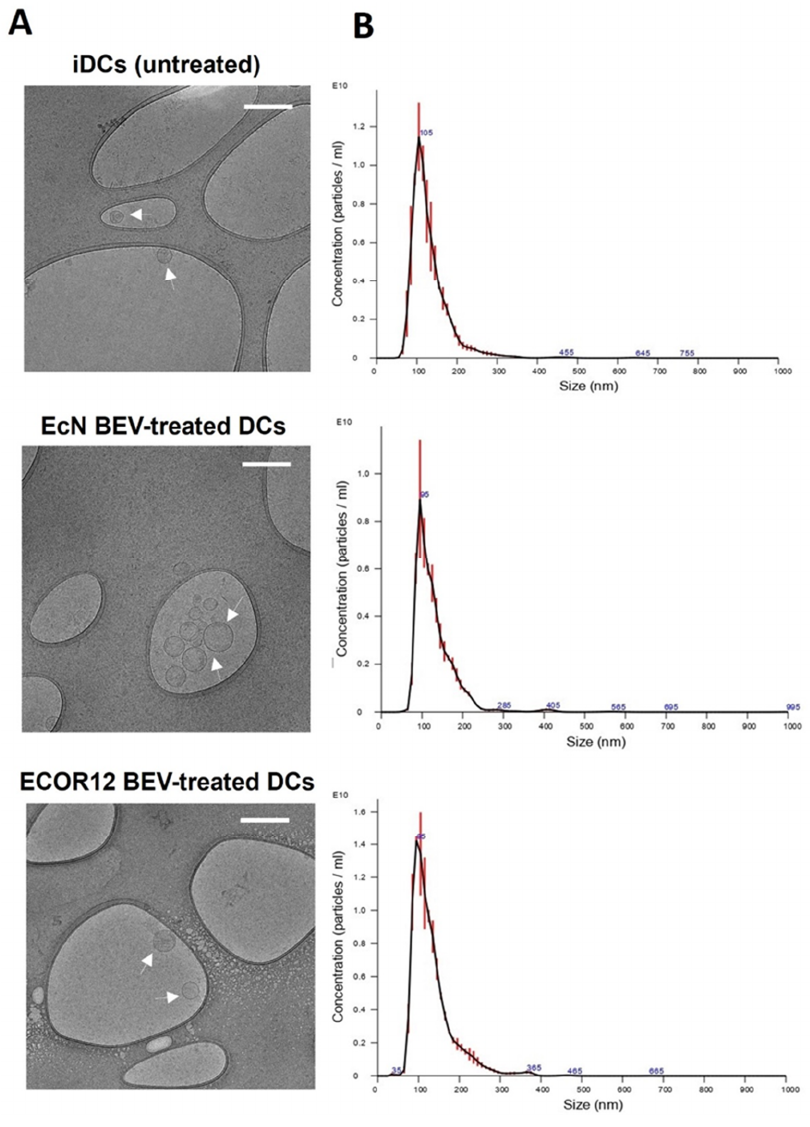
Figure 3. Characterization of EVs produced by mo-DCs in response to BEVs from the probiotic EcN or the commensal ECOR12. DC-derived EVs were isolated from culture supernatants by differential ultracentrifugation. Samples correspond to the final 100,000× g pellet. ( A ) Cryo-TEM observation of EV samples collected from iDCs (untreated) or DCs treated with vesicles from the indicated strains. Representative images of plunge-frozen EVs are shown. Scale bars: 200 nm. ( B ) Particle size distribution analyzed by nanoparticle tracking analysis and processed using NTA software (NanoSight). The data represent the mean ± SEM (error bars) of three independent